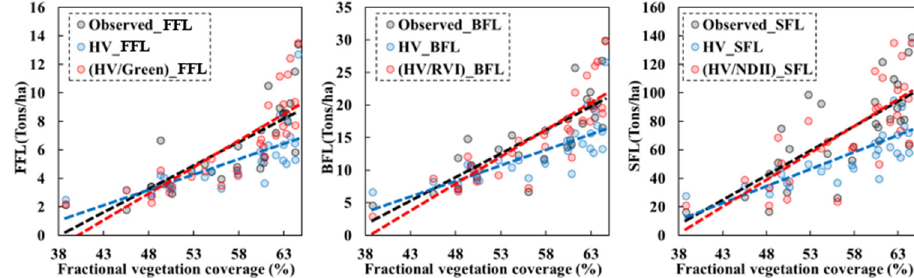
Figure 5. Comparison of model performance with different vegetation coverage.